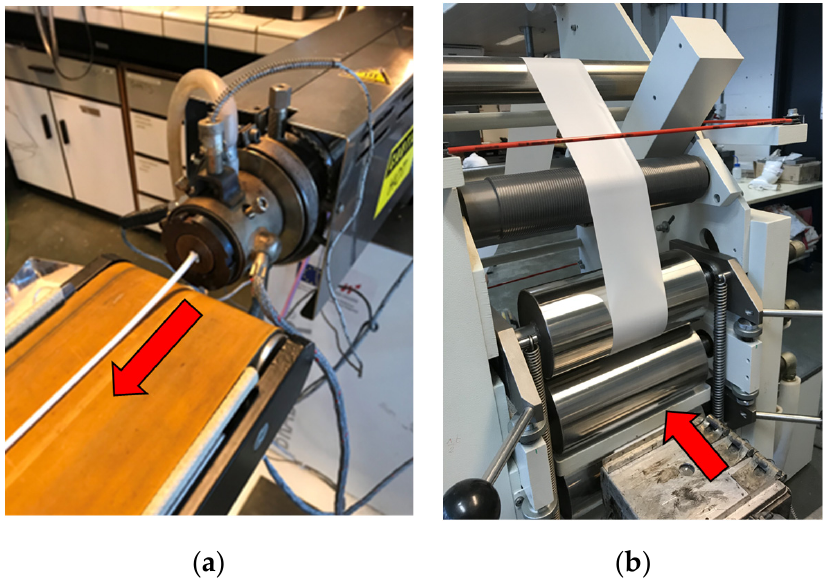
Figure 3. ( a , b ) Laboratory tests to produce: ( a ) tubes and ( b ) films of plasticized composites. The red arrows show the machine direction for the extrusion of tubes and films.